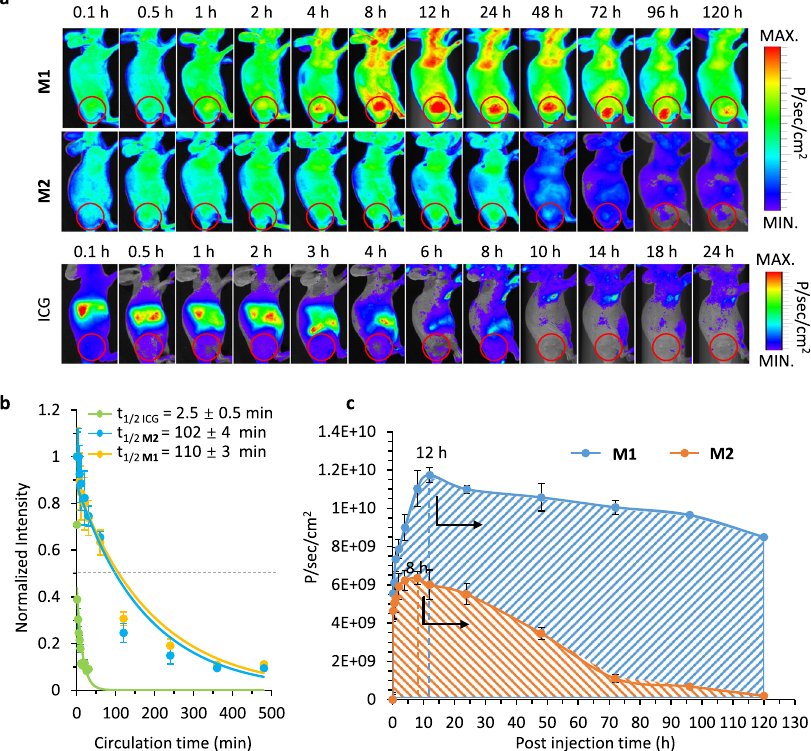
Fig. 6 The BIVA effect optimized the metabolism of the probe in vivo. a The time-dependent NIR fl uorescence image of mice bearing MIA PaCa-2 cells after intravenous administration of ICG, M2 and M1 with a dose of 16 mg/kg. The images acquired at time intervals from 0.1 h to 120 h are managed with the same procedure (The circles represent the locations of the tumors). b The blood circulation curve of ICG, M2 and M1 based on exponential curve fi tting. The t 1/2 value was the blood circulation half-life. c The time-dependent quantitative calculation of the average and the area under the curve (AUC) of ICG, M2 and M1 . The mean of three biological replicates is shown and data are presented as mean values± SD ( n =